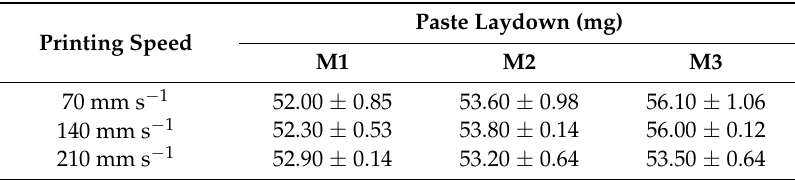
Table 2. Paste transfer for model silver pastes M1, M2, and M3 obtained through 50 µ m finger opening at different printing velocities 70, 140, and 210 mm s − 1 .